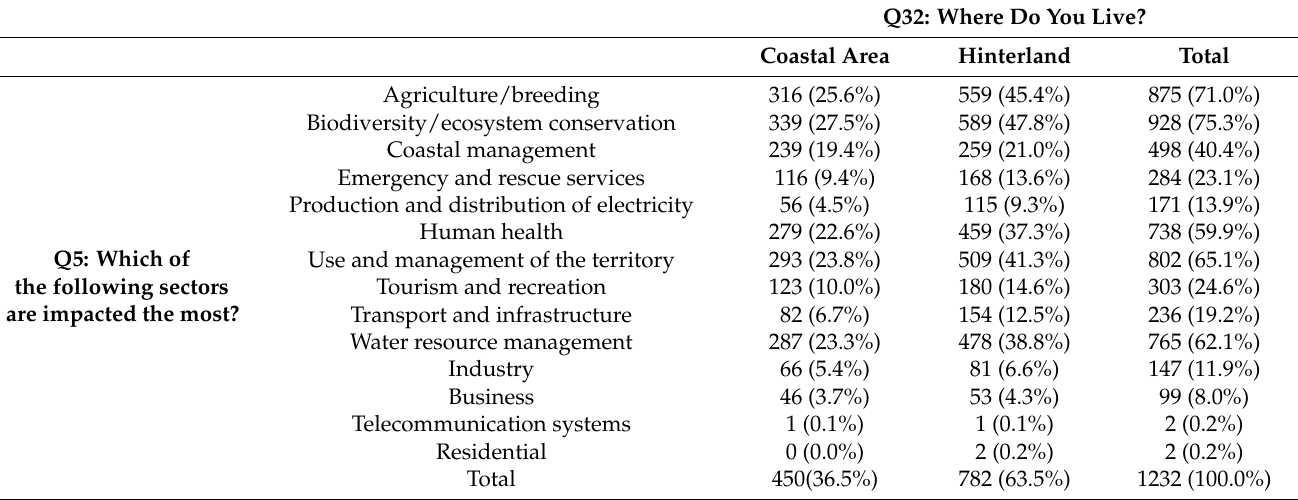
Table 9. Cross table of Q5 and Q32 with frequencies (percentages) of the answers.